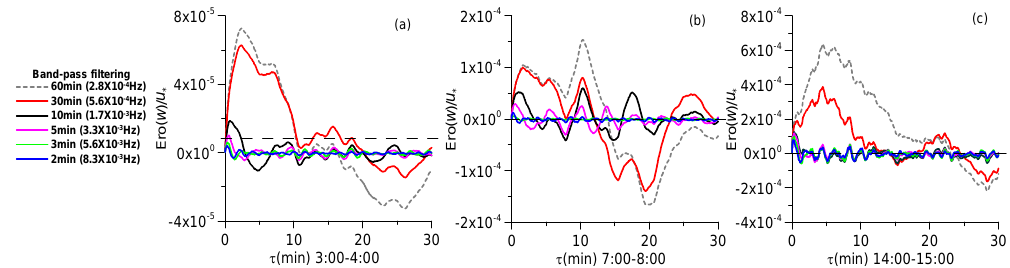
Figure 1. Variation of mean ergodic function Ero( w ) of vertical velocity measured at the height 3.08m in NSPCE with relaxation time for the different scale eddies after band-pass filtering. (a) , (b) and (c) are the respective results of the three time frames. If their mean ergodic function is more approximate to 0, then eddies in the corresponding temporal scale will more closely satisfy the ergodic conditions.